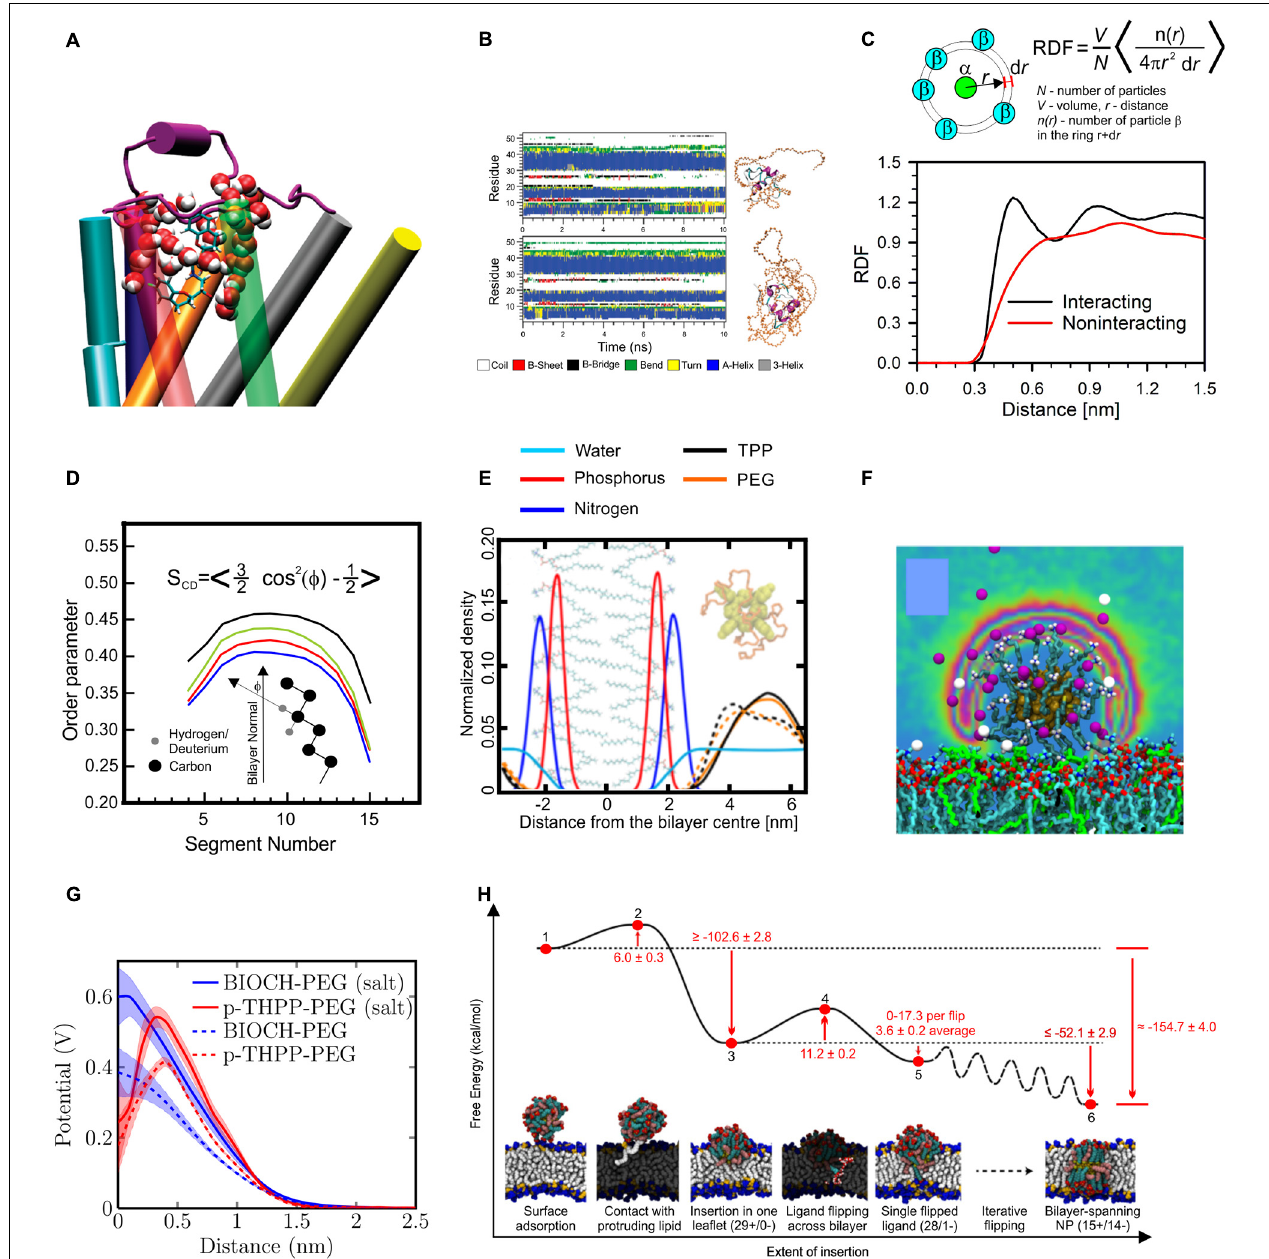
FIGURE 3 | Results of MD simulations. (A) Snapshot showing involvement of water in binding mode of nebivolol to β 2-adrenergic receptor, reproduced with permission from Kaszuba et al. (2010), Copyright (2010) American Chemical Society. (B) Time evolution of secondary structure of PEGylated insulin molecules, reproduced with permission from Yang et al. (2011), Copyright (2011) American Chemical Society. (C) An example of radial distribution functions (RDF) for interacting particles (black line) and non-interacting particles, data taken from Roìg and Pasenkiewicz-Gierula (2004). (D) Example of order parameter profile along the lipids acyl chain, reproduced from Mobarak et al. (2018) (CC BY 4.0). (E) An example of density profile showing position of atoms of lipid headgroups (phosphorus and nitrogen) and PEGylated tetra-phenyl-porphyrin (PEG and porphyrin densities are shown separately), at the presence (dashed line) and absence (solid line) of salt in solution, reproduced with permission from Rissanen et al. (2014), Copyright (2014) American Chemical Society. (F) Distribution of counter ions around gold nanoparticle functionalized with hydrocarbons capped with amine group, reproduced with permission from Heikkilä et al. (2014a), Copyright (2014) American Chemical Society, (G) electrostatic potential profile around PEGylated Biochanin (BIOH) and tetra-phenyl-porphyrin (p-THPP) in the presence and absence of salt in solution, reproduced with permission from Rissanen et al. (2014), Copyright (2014) American Chemical Society; (H) free energy landscape for the process of insertion of dendrimer into lipid bilayer, reproduced from Van Lehn and Alexander-Katz (2019), Copyright: 2019 Van Lehn, Alexander-Katz.